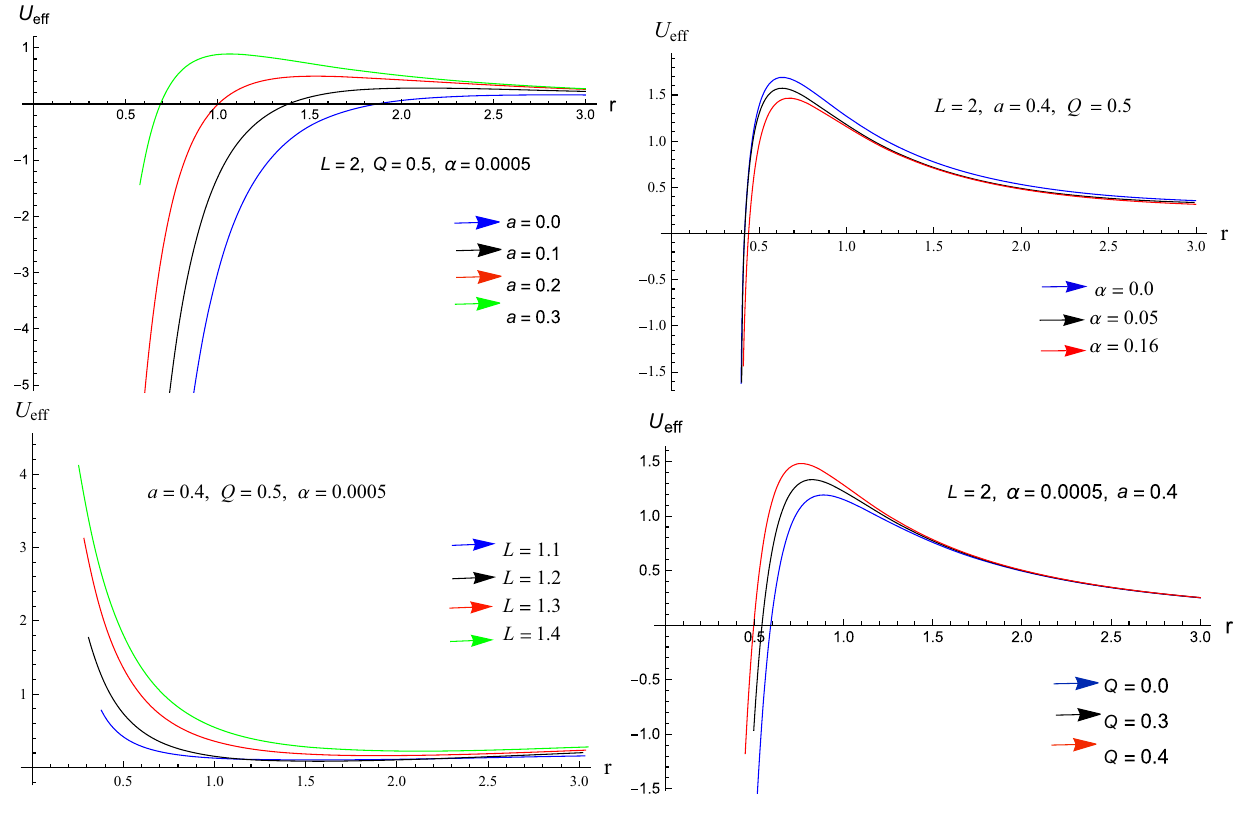
Fig. 4 Plots of effective potential for null geodesics as a function of r for ω = − 1